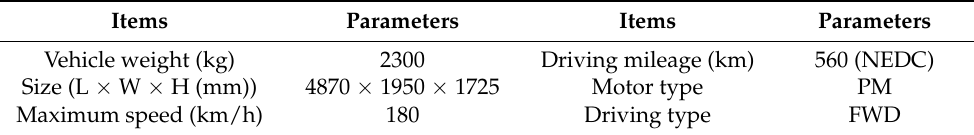
Figure 6. Picture of the 4-DYNO test bench. Table 1. Some parameters of the electric vehicle under